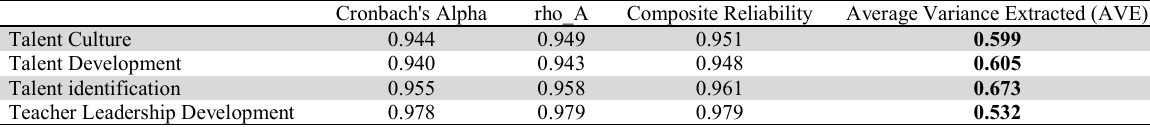
Results of measurement model-Convergent validity